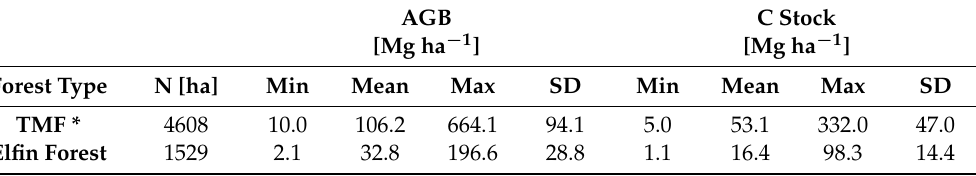
Table 3. AGB and C stock in the San Francisco catchment.